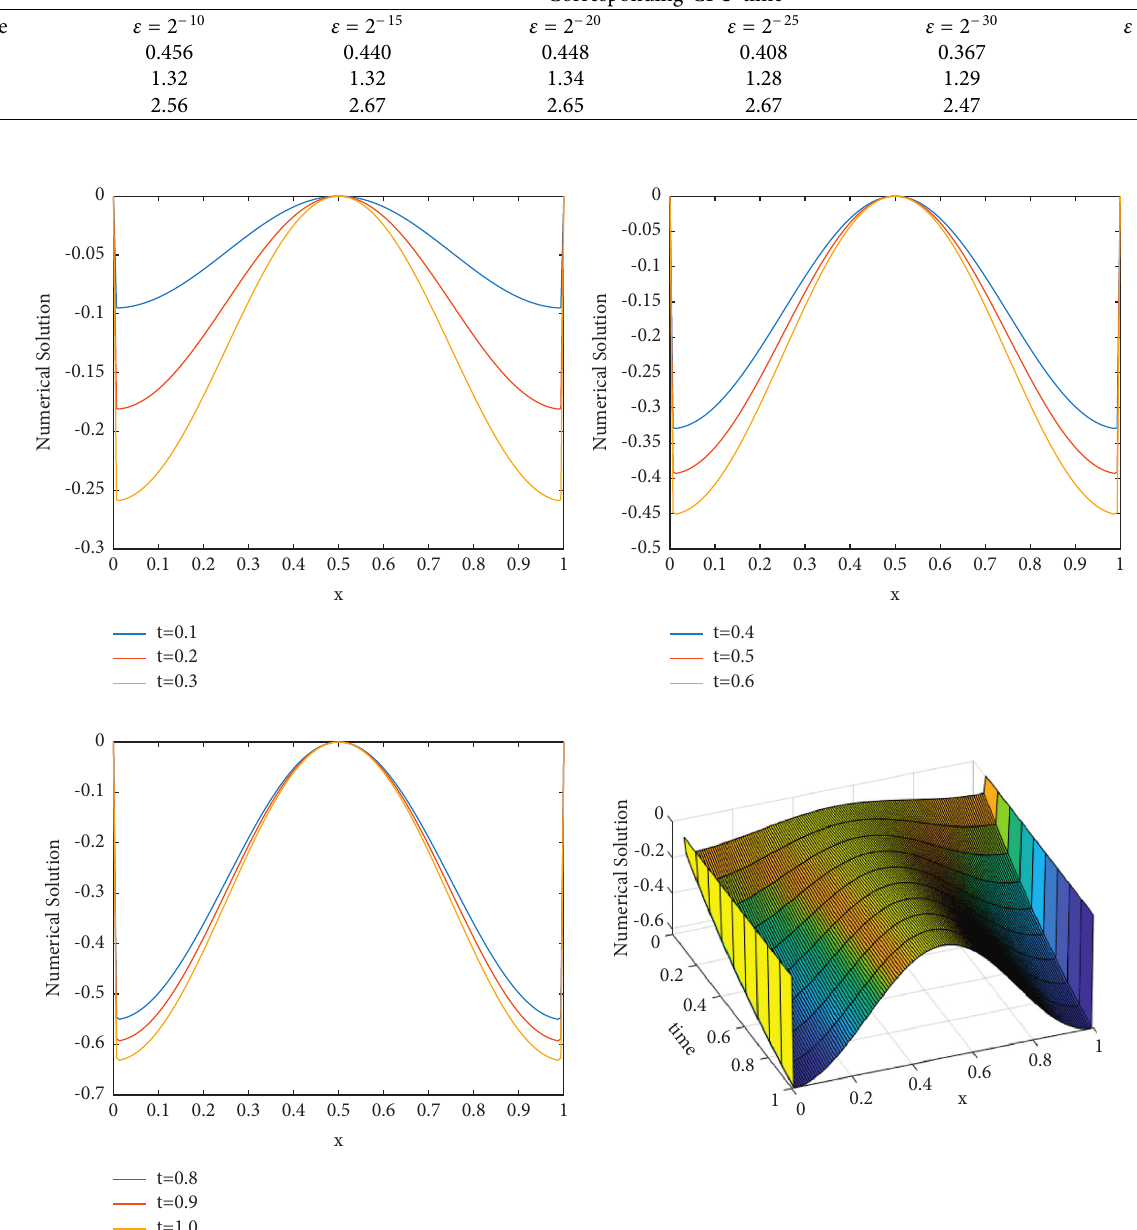
Figure 3: Solution behavior of the mode at different time with parameter ε � 2 − 20 and M �